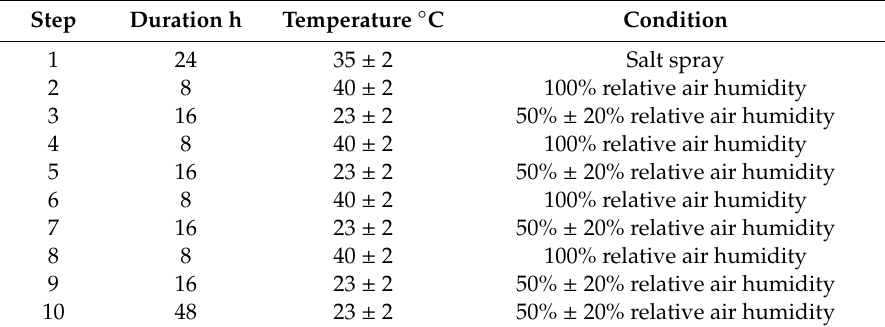
Table 2. Test parameters of the cyclic climate change